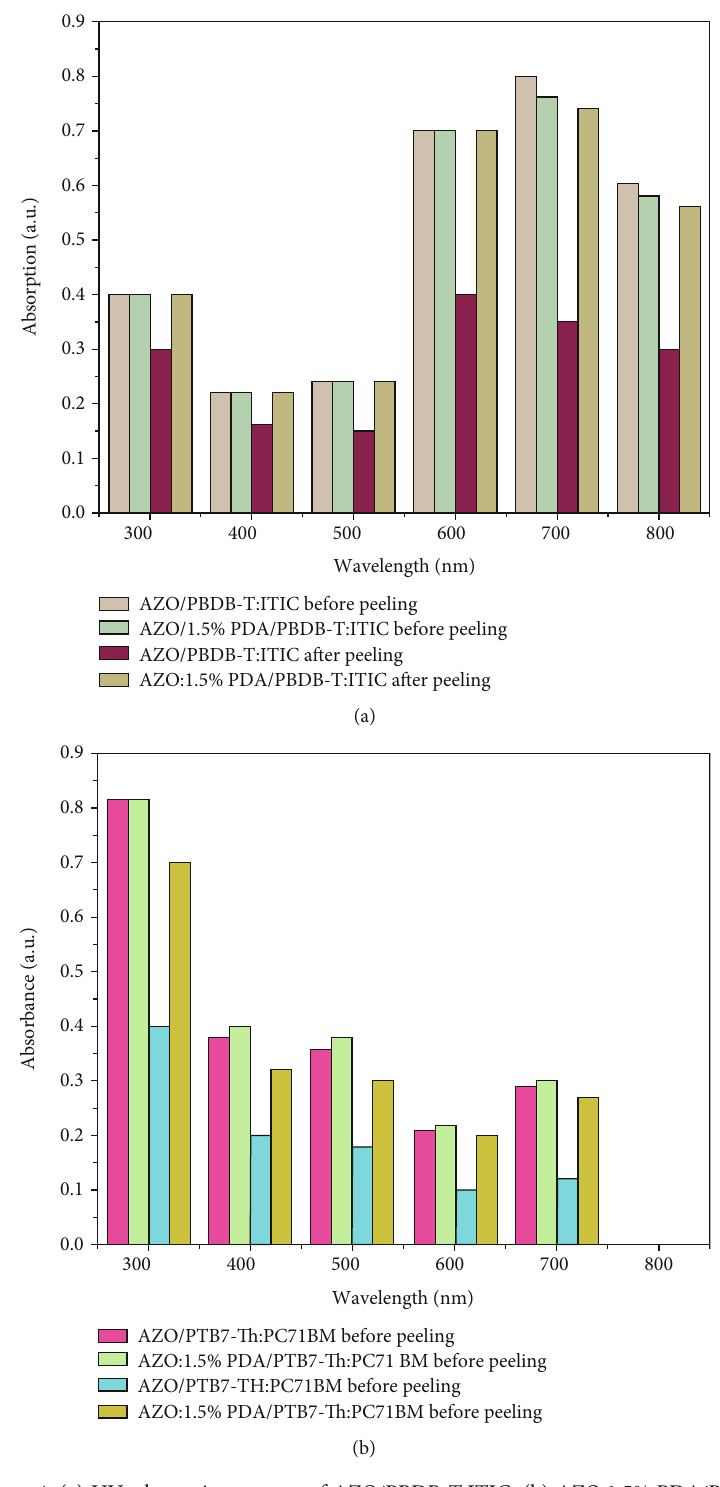
Figure 4: (a) UV – absorption spectra of AZO/PBDB-T:ITIC. (b) AZO:1.5%